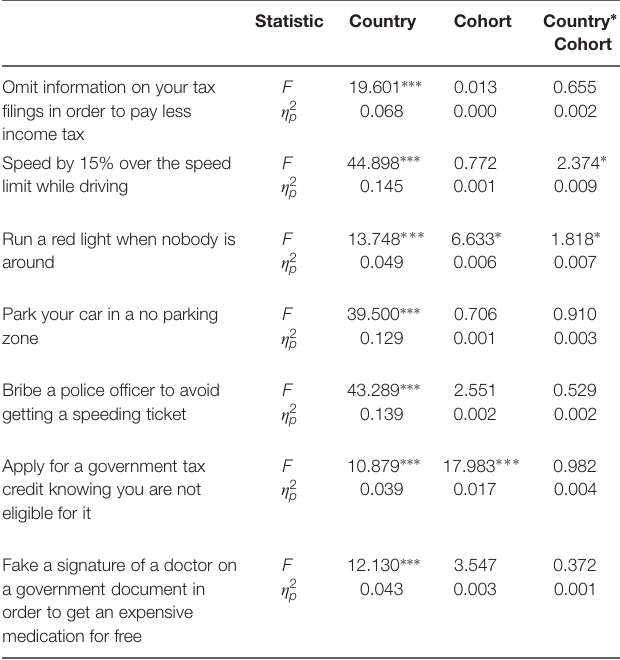
TABLE 1 | Summary of univariate ANOVAs comparing responses across countries and cohorts regarding the likelihood of engaging in seven dishonest